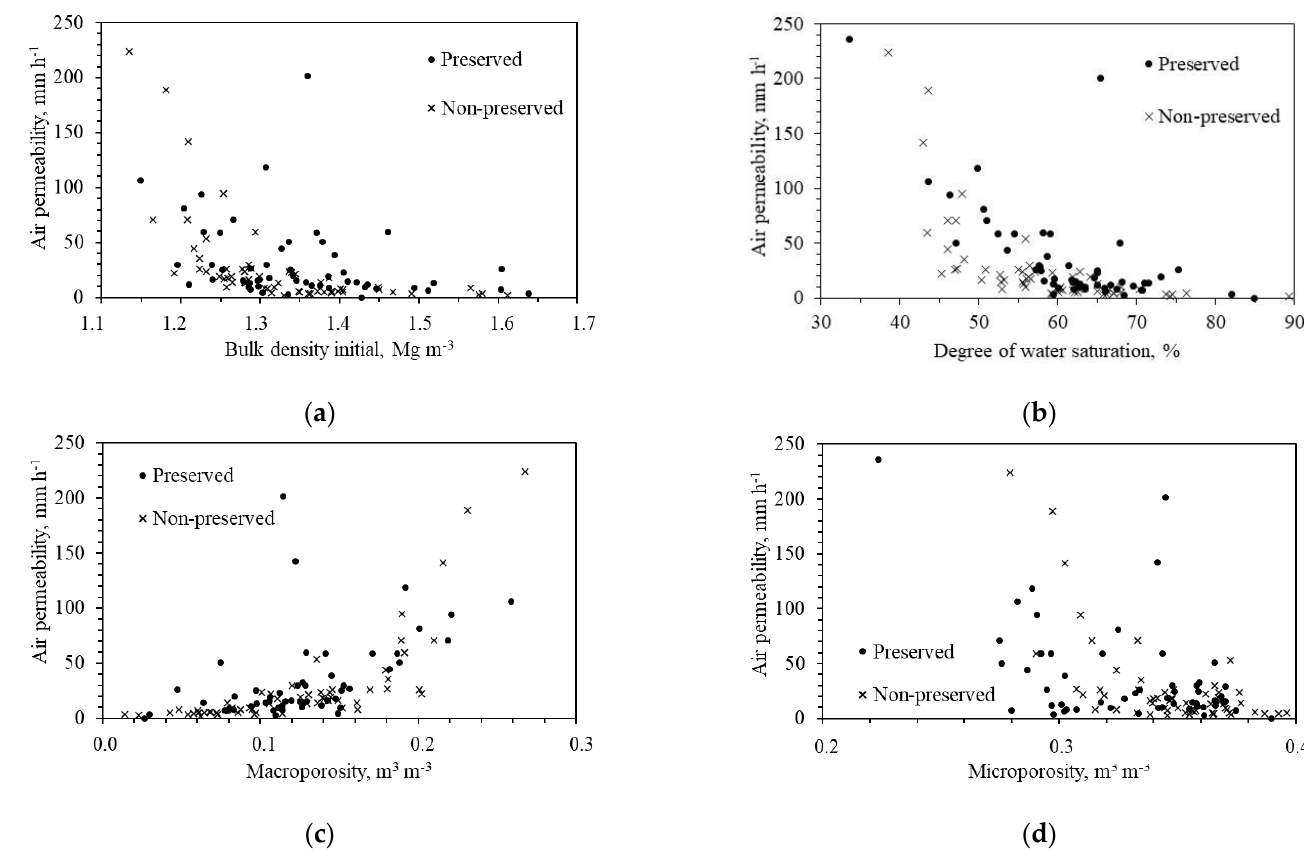
Figure 9. Regression between physical properties for soil with preserved and non-preserved structure. Soil structure condition (preserved or not) had few influences on bulk density, macro- porosity, total porosity, air permeability, and precompression stress ( p > 0.05).